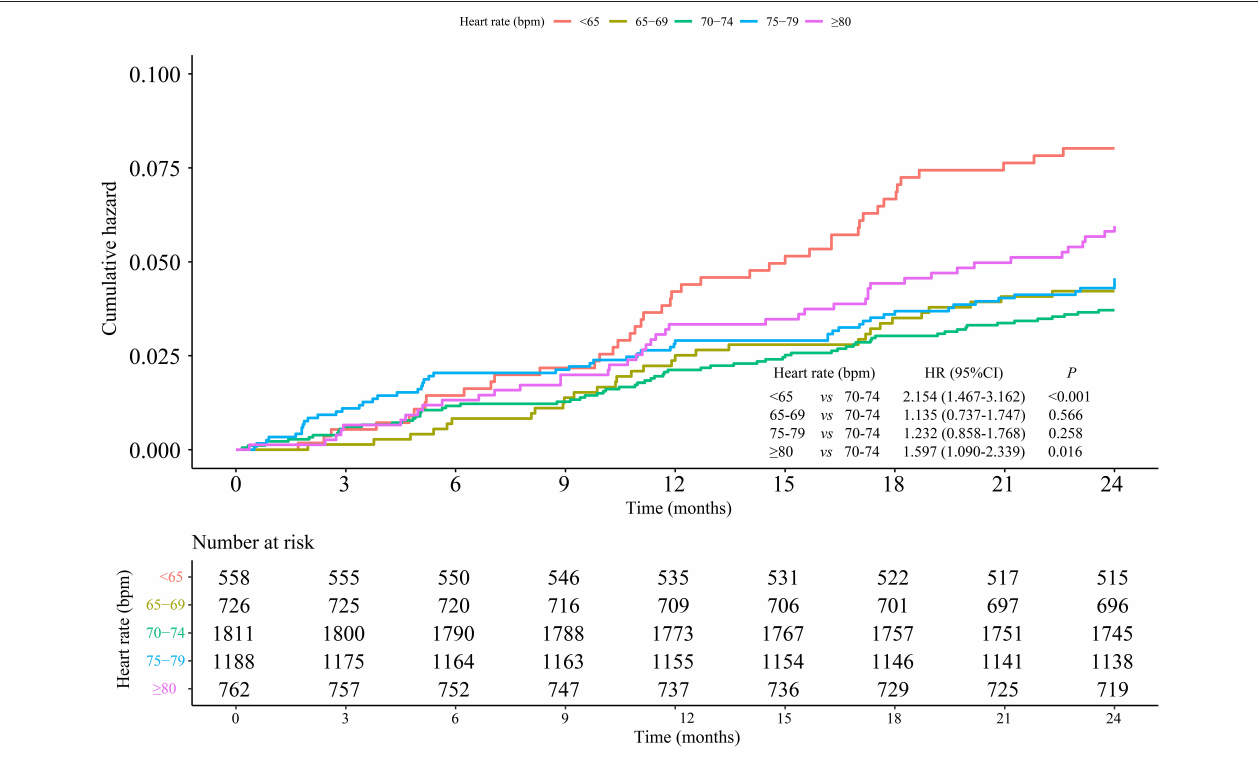
FIGURE 4 | Association between heart rate and MACE risks in hypertensive male